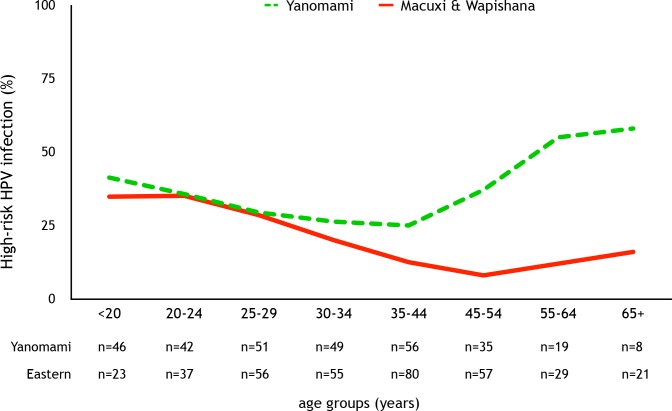
Prevalence of high-risk HPV by age group.